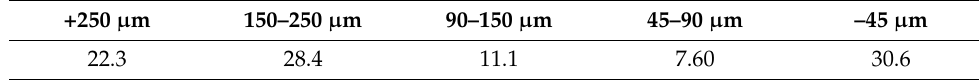
Table 1. Particle size distribution of lithium-bearing bauxite (%).